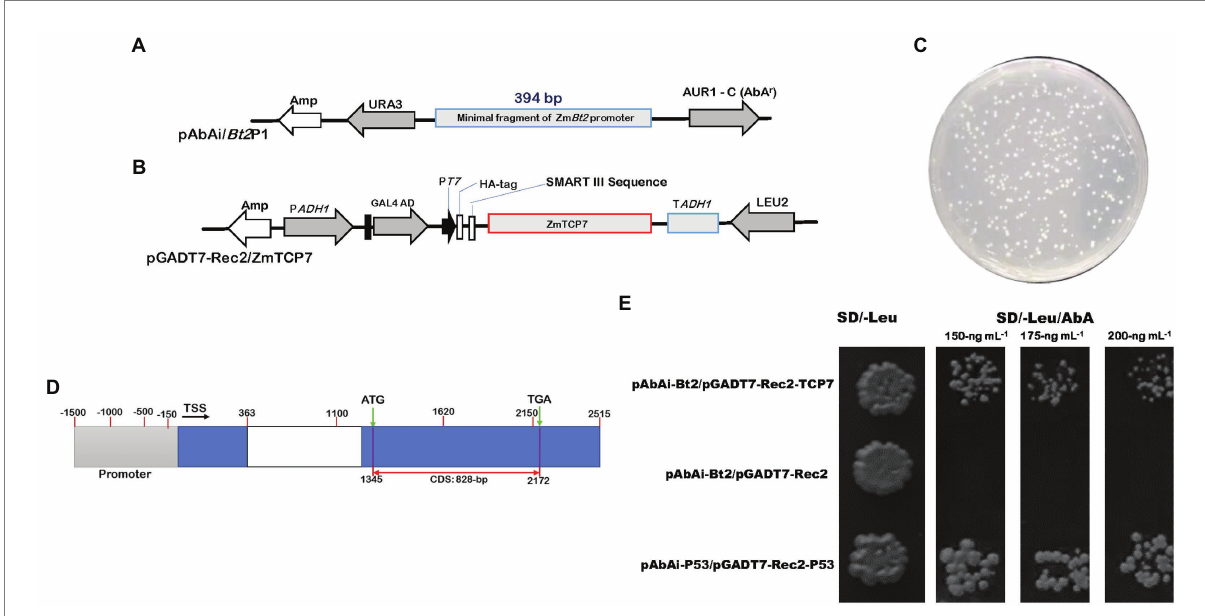
FIGURE 1 Detection of positive transformants and specific interaction between ZmTCP7 and the ZmBt2 promoter in a yeast-one hybrid system. (A,B) Schematic diagrams of the bait (pAbAi/ Bt2 P1) and prey protein (pGADT7-Rec2/ZmTCP7) constructs, respectively. AUR1-C/AbA r is an antibiotic reporter gene that confers resistance to the Aureobasidin A (AbA) antibiotic. AbAr expression is driven by positive DNA-protein interactions. URA3 and Leu2 are yeast selectable nutritional markers for yeast replication and selection. The bait (pAbAi/ Bt2 P1) contains the fragment of ZmBt2 promoter (p Bt2 P1; 394-bp) fused upstream of the AbA r reporter gene, while the construct of the prey protein (pGADT7-Rec2/ZmTCP7) harbors GAL4-AD/ZmTCP7 fusion protein; (C) 100 − 2 dilution of library transformants screened in SD/-Leu selective medium supplemented with an AbA antibiotic of 150 ng ml − 1 concentration; (D) Schematic diagrams of the ZmTCP7 genome model showing the promoter region (gray rectangle), exons (blue rectangle), intron (white rectangle), transcription start site (TSS), and the complete coding sequence (CDS); (E) 100 − 2 dilution of yeast transformants screened on two selective medium: (i) SD/-Leu and (ii) SD/-Leu supplemented with different concentrations of AbA antibiotic: 150 ng ml − 1 , 175 ng ml − 1 , and 200 ng ml − 1 . The transformants harboring pAbAi- Bt2 P1/pGADT7-Rec and pAbAi-P53/pGADT7-Rec-P53 were used as negative and positive control systems,